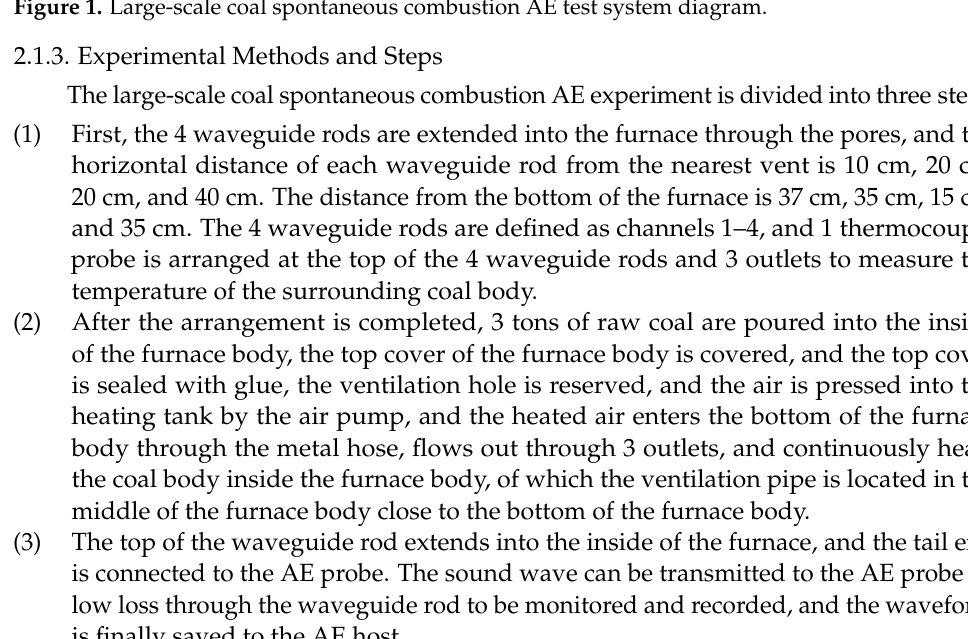
Figure 1. Large-scale coal spontaneous combustion AE test system diagram.